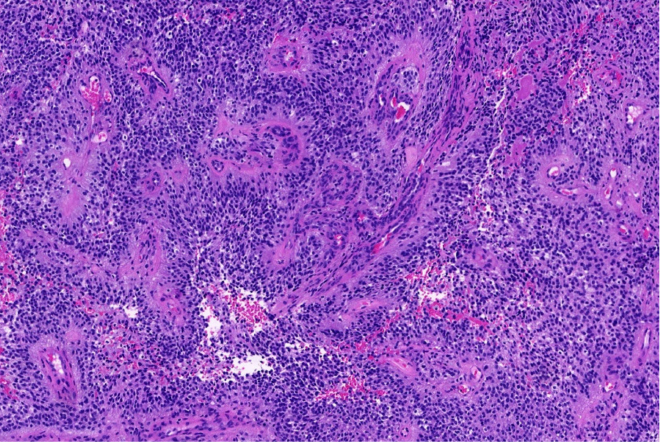
Figure 2. EWSR1 -PATZ sarcoma with small blue round-cell morphology (HE; 20 × magnification).